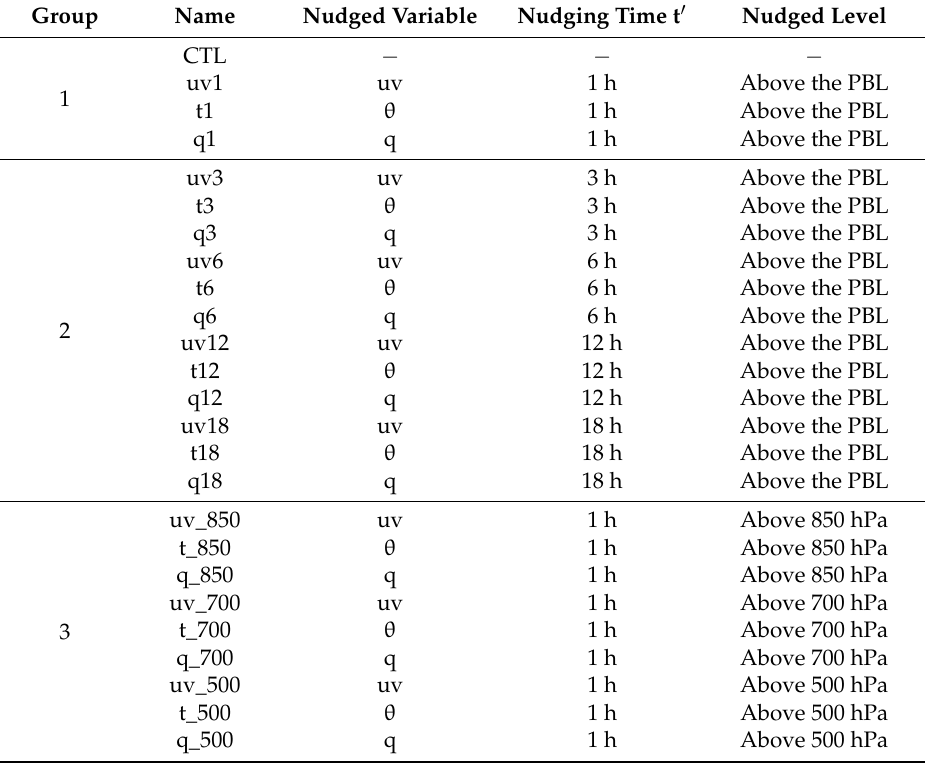
Table 1. Experiment design (PBL denotes planetary boundary layer, uv denotes horizontal wind, θ denotes potential temperature, and q denotes water vapor mixing ratio. Groups 1 and 2 were performed in summer 2009 and 2010, and Group 3 was performed in summer